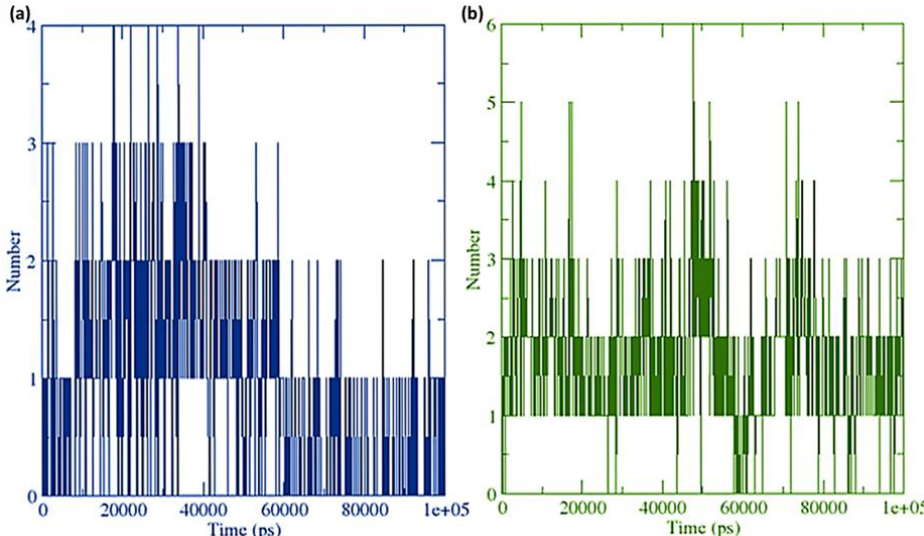
Figure 15. Number of average hydrogen bonding interactions between ( a ) the RisS complex and ( b ) the CTcS complex during the 100 ns simulation